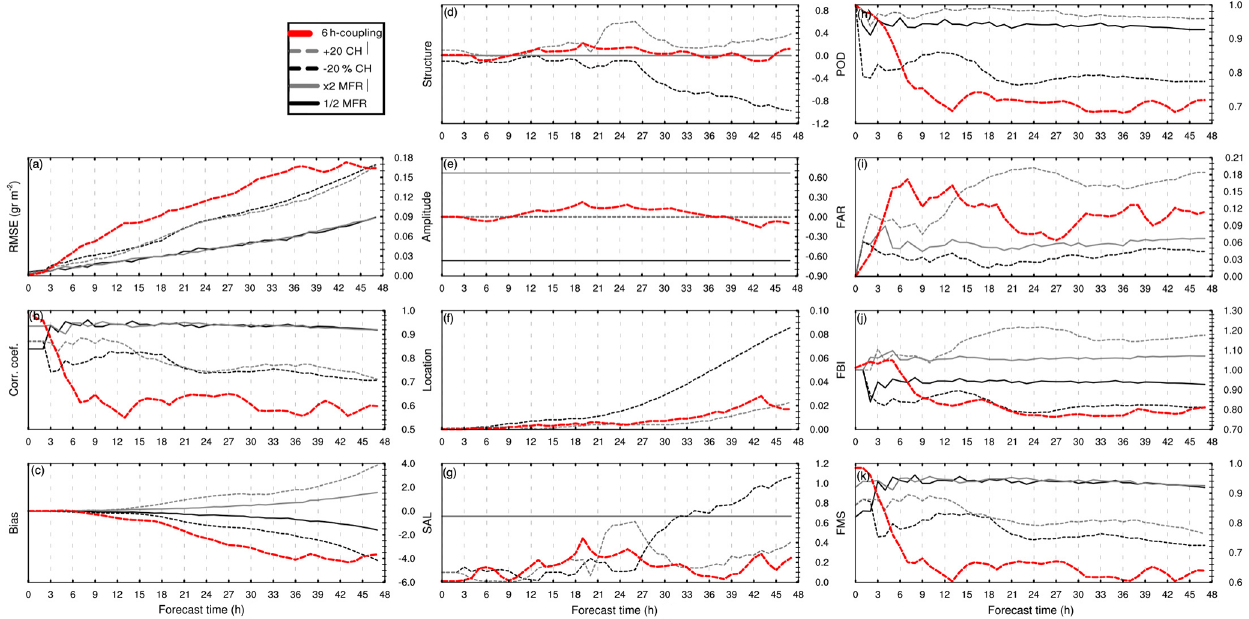
Figure 15. Online vs. offline evaluation scores for the NMMB-MONARCH-ASH synthetic application representing the uncertainty associ- ated with the source term. ESPs were modified for the eruption column height ( ± 20%) and MER ( × 2 and 1 / 2). Scores are compared with those from the 6h offline coupled forecasts (red